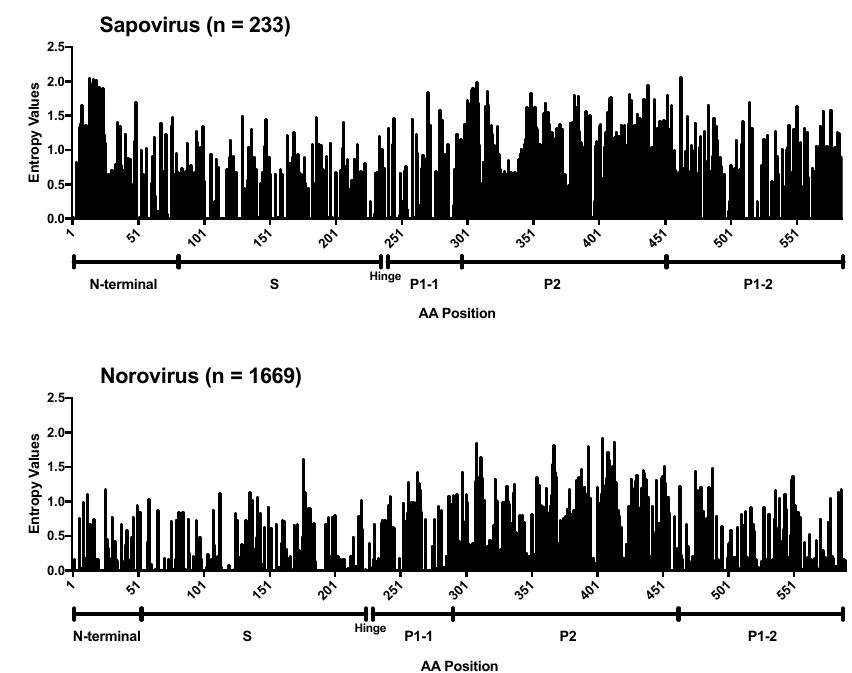
Figure 5. Conservation analyses of the VP1 capsid protein from sapovirus. Shannon entropy values were calculated to quantify the amino acid variation for the capsid protein VP1 from human sapovirus GI, GII, GIV, and GV strains. Sapovirus dataset includes human sapovirus GI, GII, GIV, and GV strains ( n = 233). Norovirus dataset includes human norovirus GI and GII strains ( n = 1669). Position of amino acid residues was based on the multiple sequence alignments including indels. Structural domains were assigned based on the sapovirus strain GI.1 / Mc114 (AY237422) [3] and norovirus strain GI.1 / 8FIIa (M87661) [49].